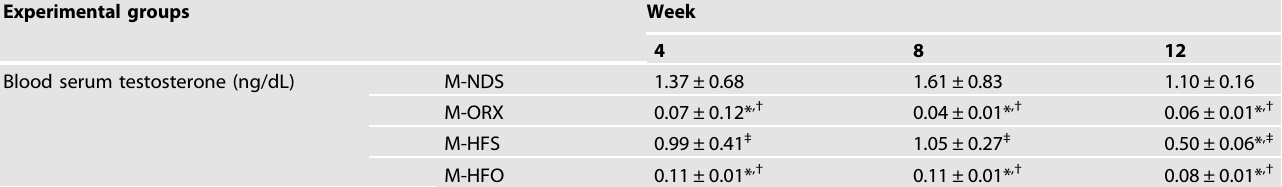
Table 1. Summary of blood serum testosterone